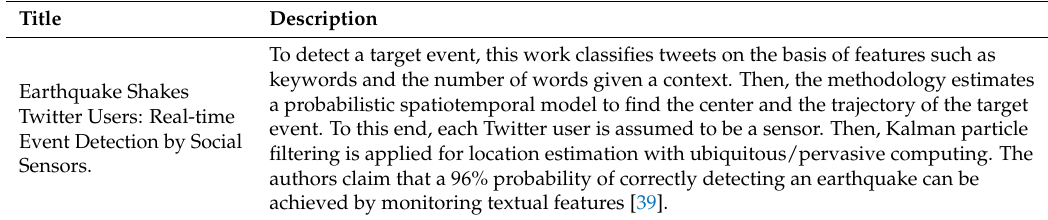
Table 1. Related work that contributes to natural disaster sensing using data extracted from Twitter and other OSNs.